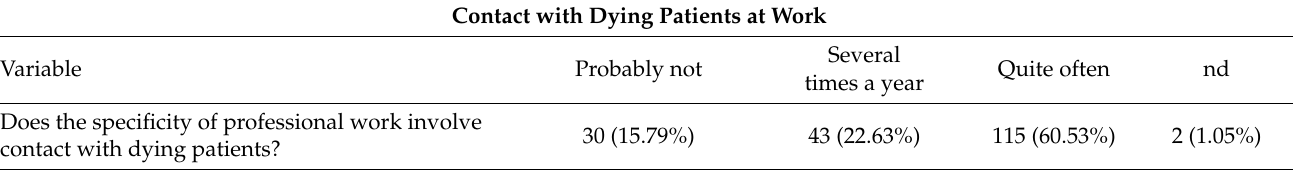
Table 2. Work experience and employees’ views on futile therapy (numbers and percentages in